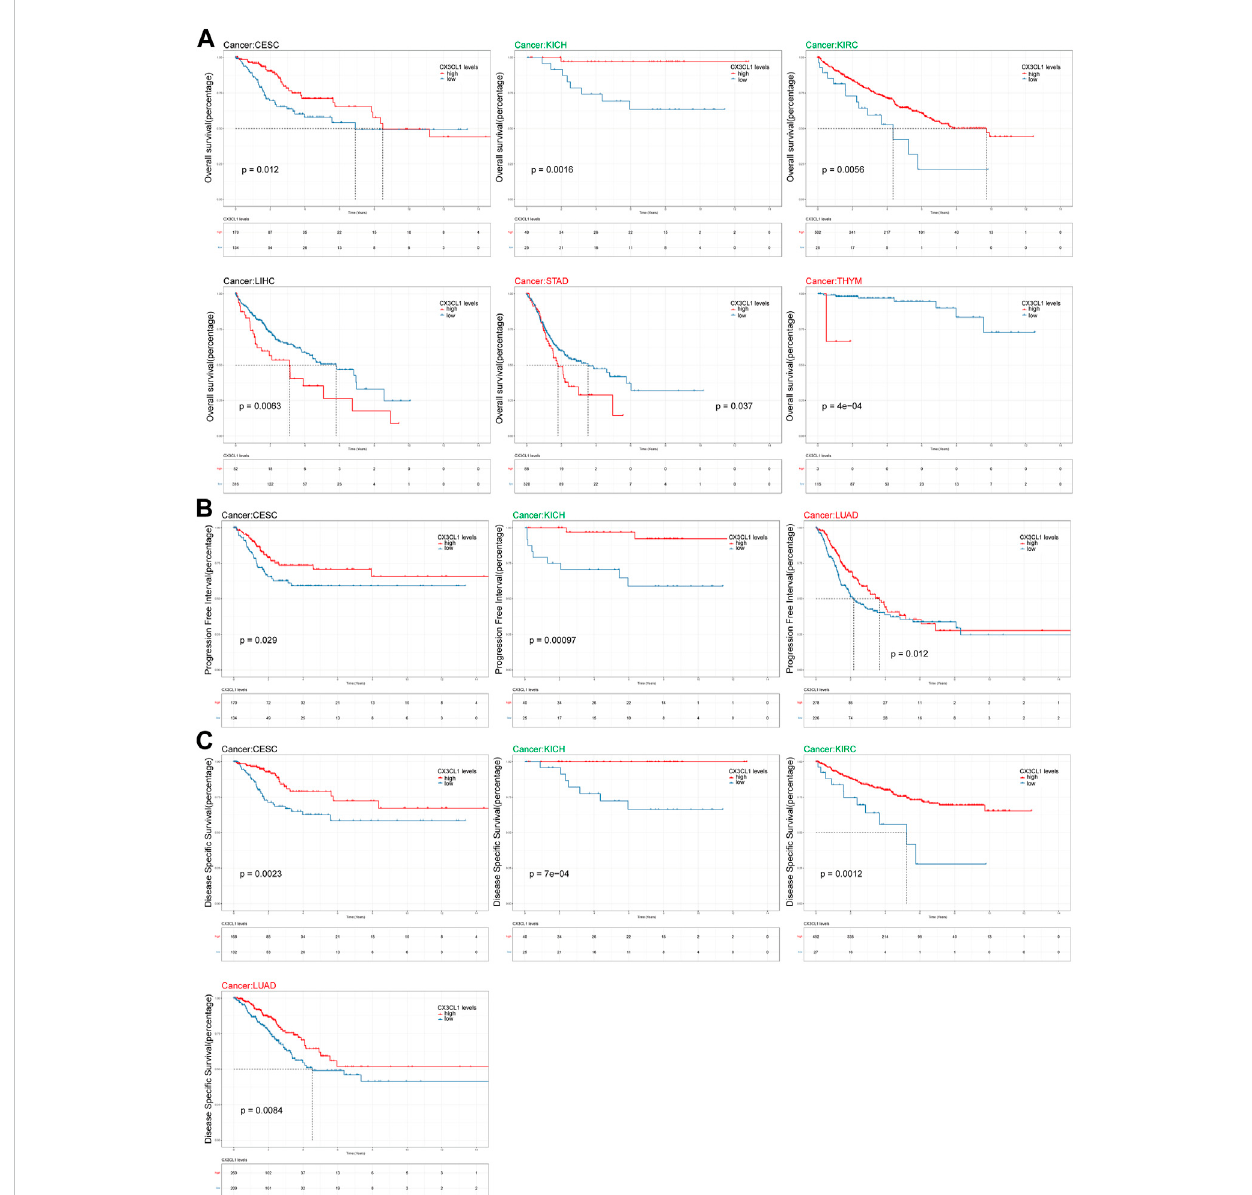
FIGURE 4 AnalysisoflinkbetweenCX3CL1expressionlevelandprognosis. (A) TheKaplan-Meiercurveofoverallsurvival(OS)inCESC,KICH,KIRC,LIHC,STAD, and THYM. STAD and THYM are members of the upregulated group, while KICH and KIRC are members of the downregulated group. (B) The Kaplan- Meier curve of progression free interval (PFI) in CESC, KICH, and LUAD. LUAD are members of the upregulated group, while KICH are members of the downregulated group. (C) The Kaplan-Meier curve of disease speci fi c survival (DSS) in CESC, KICH, KIRC, and LUAD. LUAD are members of the upregulated group, while KICH and KIRC are members of the downregulated